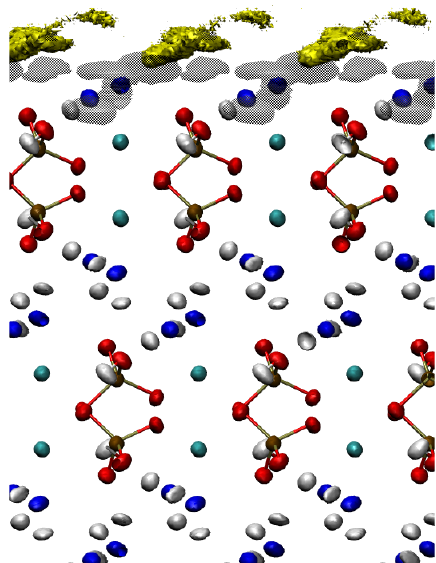
Figure 4. The atom density isosurfaces for brushite and water averaged over the molecular dynamics simulation (MD-C1). The {010} surface of CaHPO 4 · 2H 2 O is shown through the [201] plane. For the calcium and phosphate ions, H is white, O is red, P is tan, and Ca is cyan, while for the water density isosurfaces the bulk water is blue and H is white (all isosurfaces at 2 atoms/Å 3 ). Oxygens of water from beyond the first layer are shown with yellow isosurfaces and H is shown with transparent grey in the bulk region due to its diffuse distribution (both 0.05 atoms/Å 3